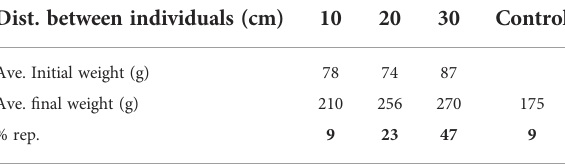
TABLE 2 Increase in weight of Eisenia arborea individuals cultured from September 2013 to April 2014 in San Quint ı ́ n Bay. Dist. between individuals